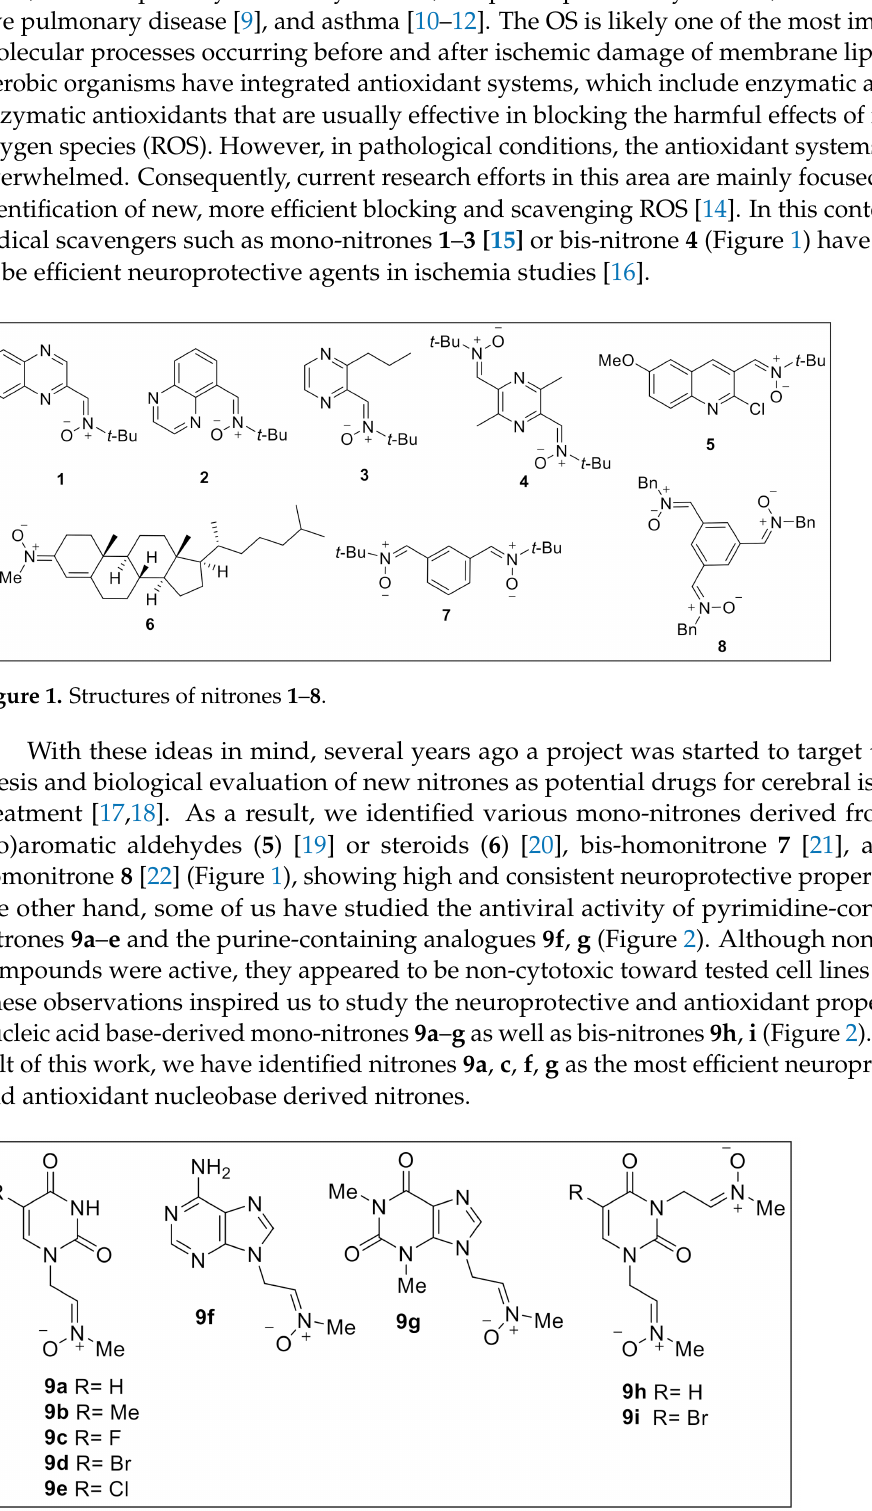
Figure 2. Structures of the nucleobase derived nitrones 9a – i investigated in this